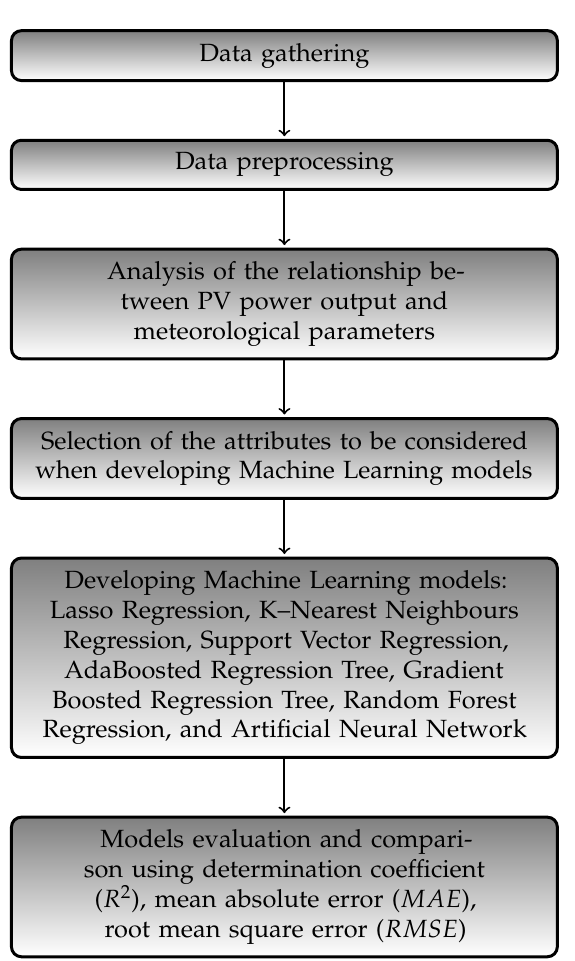
Figure 1. The proposed